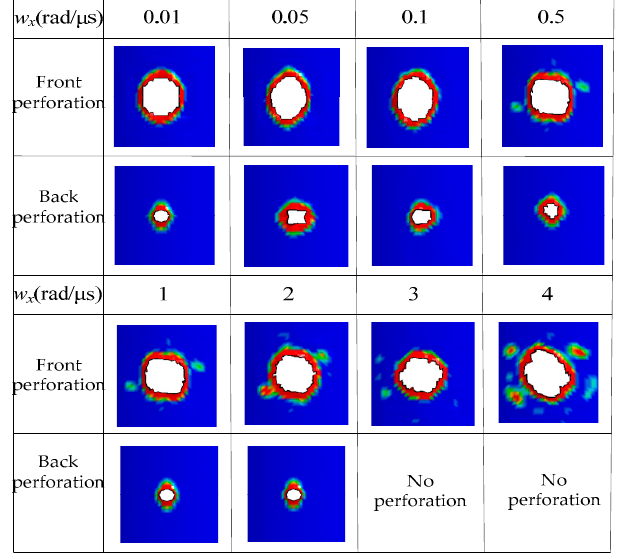
Figure 16. Front and back perforations caused by the impact of debris with angular velocities of w x = 0.01 rad/ μ s, 0.05 rad/ μ s, 0.1 rad/ μ s, 0.5 rad/ μ s, 1 rad/ μ s, 2 rad/ μ s, 3 rad/ μ s, and 4 rad/ μ s.